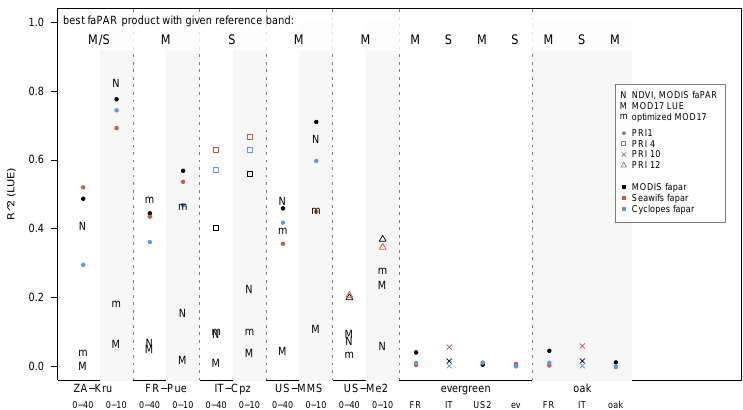
Fig. 4. R 2 of modelled vs. observed LUE using PRI with the best reference band for each site to find out the most suitable faPAR product for each setting. At each site, two ranges of sensor viewing zenith angle are shown: 0–40 ◦ and 0-10 ◦ . The best faPAR product for a given reference band is denoted with M (MODIS MOD15) and S (JRC SeaWiFS faPAR).